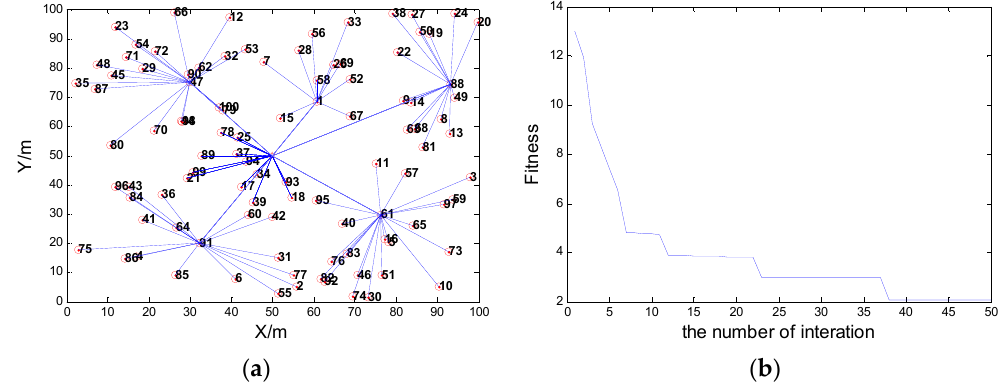
Figure 5. ( a ) The network connectivity when the communication radius R = 30; ( b ) The fitness value when the node communication radius R = 30.